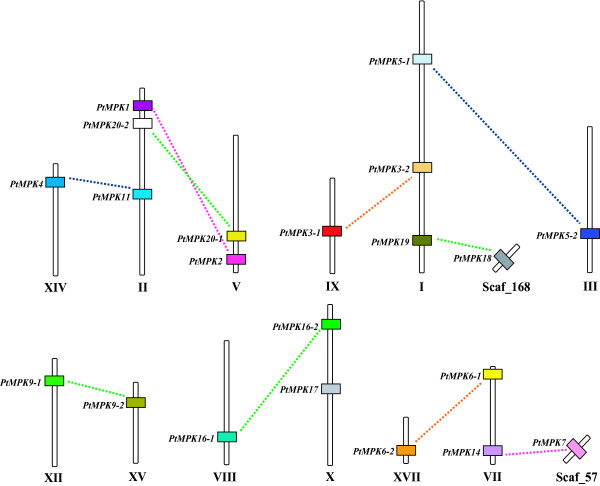
Schematic view of the scattered distribution of the poplar MAPK genes (PtMPKs) over the Populus trichocarpa genome. Twelve of the 19 poplar chromosomes are presented as vertical bars. In addition, two scaffolds containing a PtMPK gene are shown. PtMPK genes are represented by colored boxes and the color code presented here is also used in the other figures. Recent duplication events between paralogous genes are indicated using dotted lines.